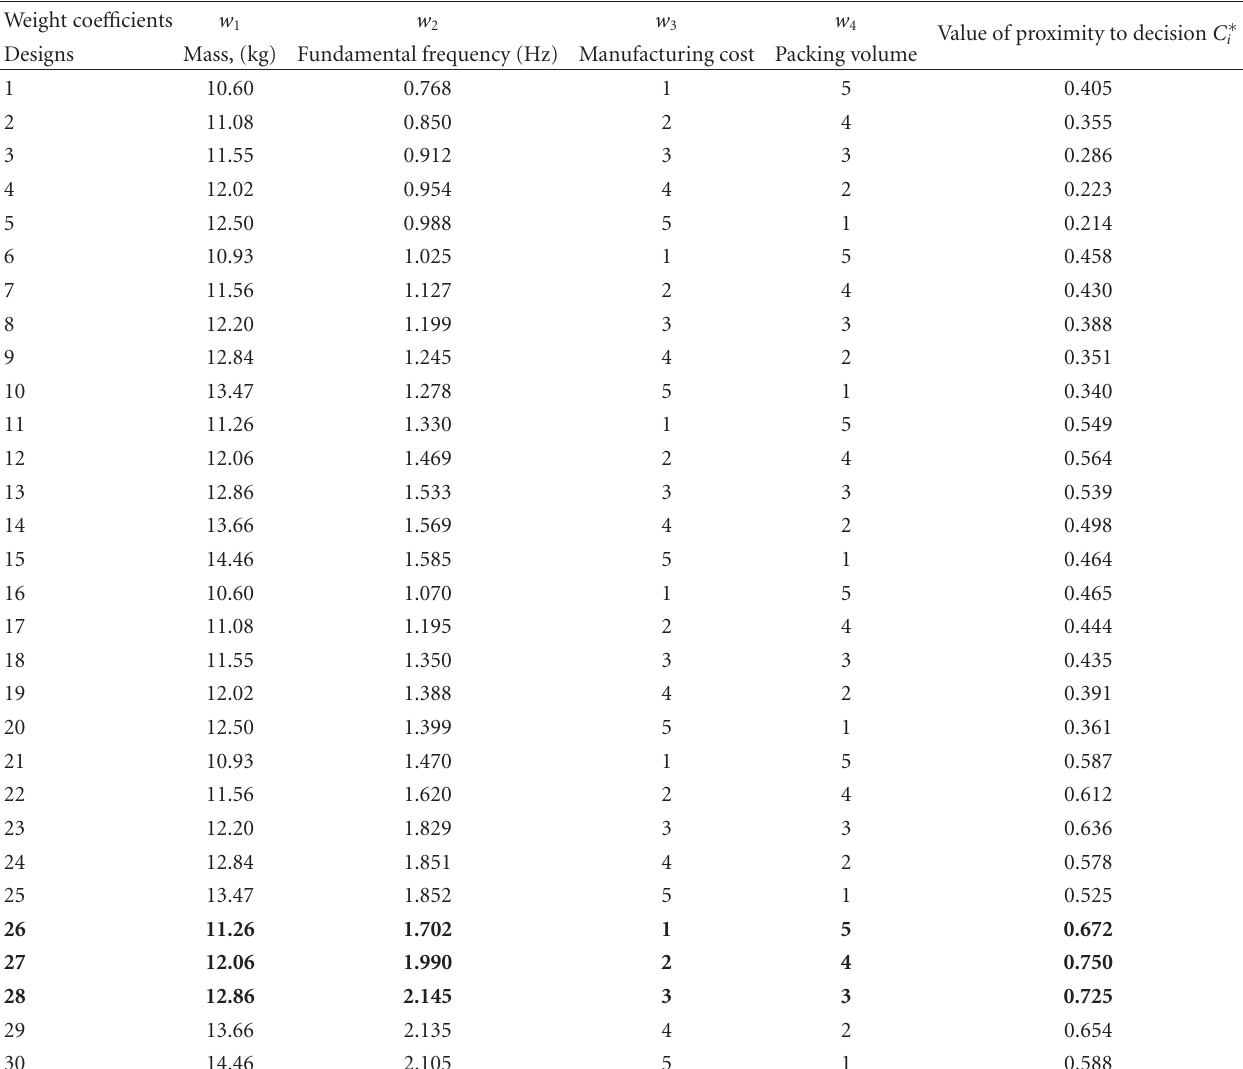
Table 4: Reflector